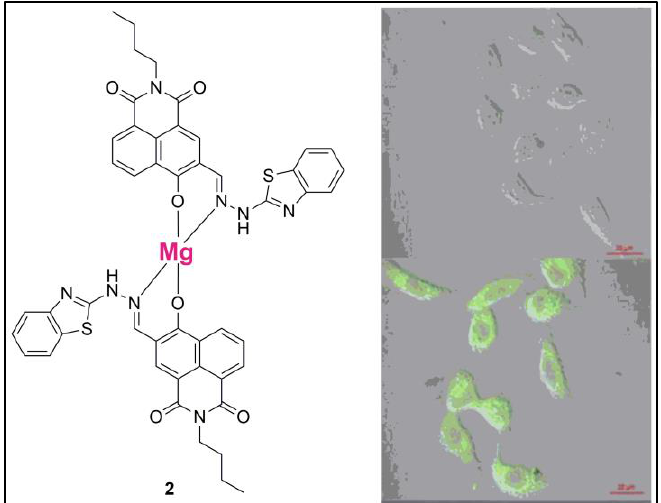
Figure 3. Proposed sensing process of probe 2 for Mg 2+ . Fluorescence image of A549 cells incubated with probe (10 μ M) for 30 min (upper panel) and then incubated with 2 μ M Mg2+ for 30 min (lower panel). Adapted with permission from [37]. Copyright (2017) Elsevier.